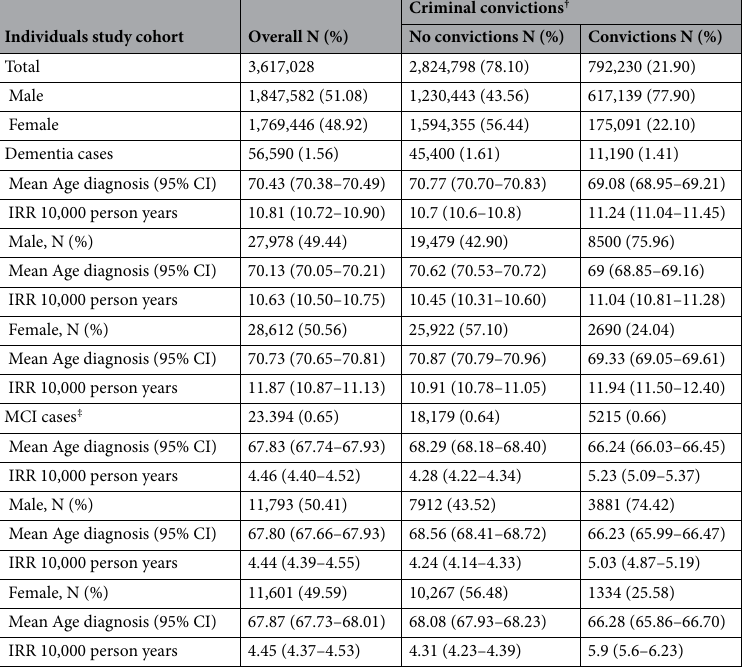
Table 1. Descriptive characteristics of the cohort according to criminal convictions. MCI Mild Cognitive Impairment, IRR Incidence Rate Ratio per 10.000 person-years. † Criminal Convictions is a time-varying exposure. ‡ For the MCI analyses the study cohort consisted of 3,616,338 individuals. There were 690 individuals delated from the main cohort due to an MCI diagnosis established before age 50 or because 0 days of follow